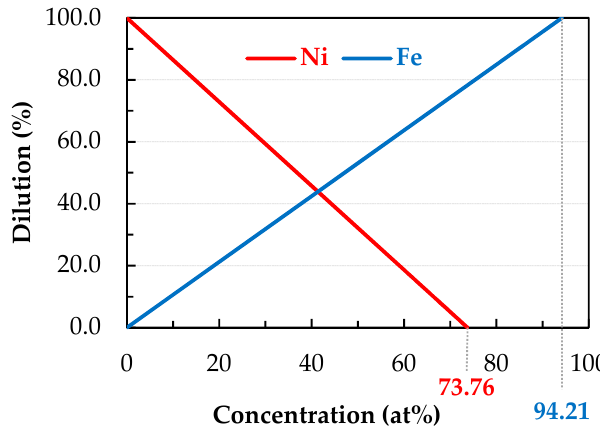
Figure 3. The dilution of FZ calculated based on Fe and Ni concentrations in quantitative WDS mappings of Figure